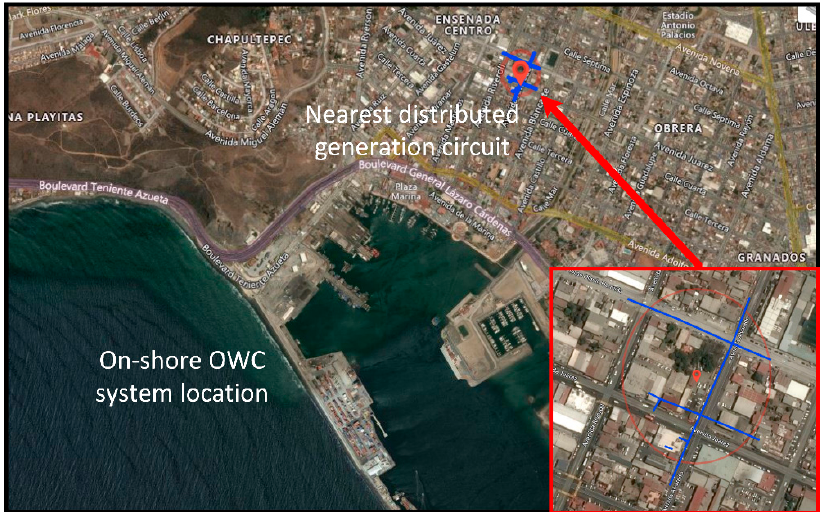
Figure 9. On-shore OWC system location proposal and nearest distributed generation circuit in Ensenada City, Baja California. Adapted from Google Maps, 2021. Ensenada City, Baja California. Adapted from Google Maps,